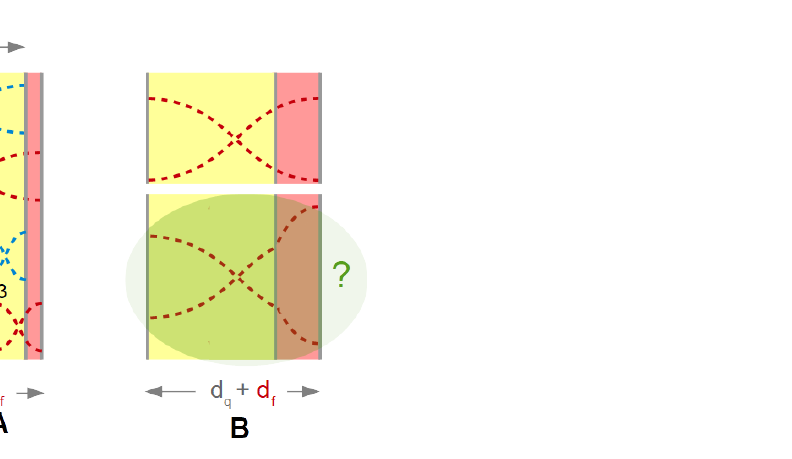
Figure 2. ( A ) A film increases the wavelength of the standing wave, thereby decreasing the reso- nance frequency. ( B ) If the film is softer than the plate, the displacement pattern has a kink at the interface. In this case, the fractional frequency shift is proportional to the fractional increase in mass (rather than